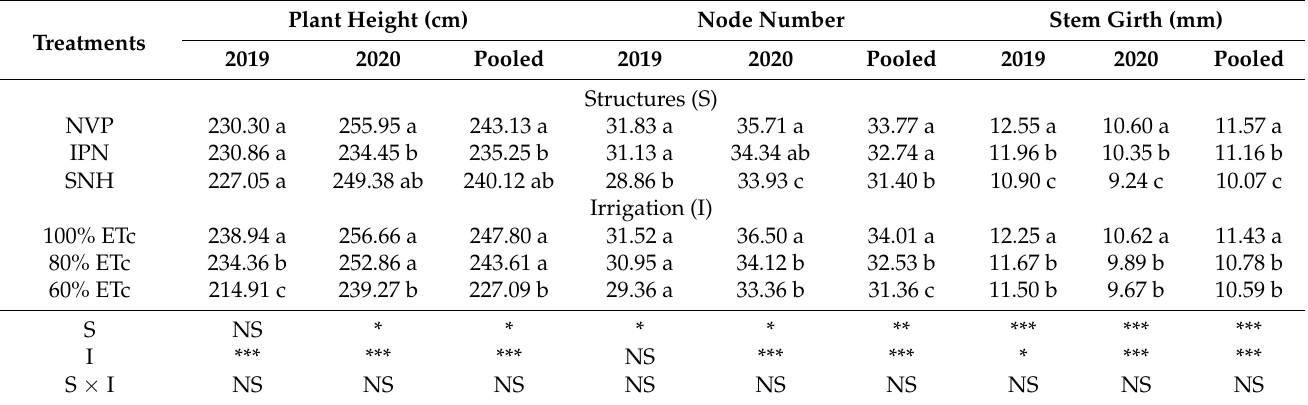
Table 4. Effect of protected structures and irrigation levels on growth parameters of tomato (plant − 1 ).